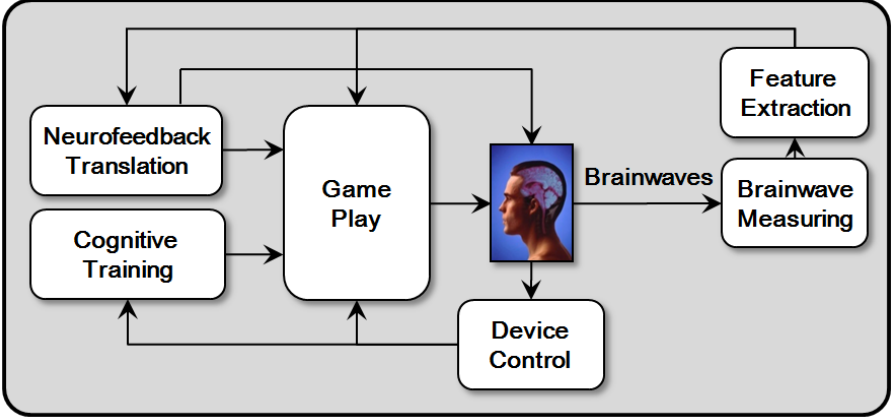
Figure 1. Hybrid Neurofeedback Model. This model contains neurofeedback and cognitive training.